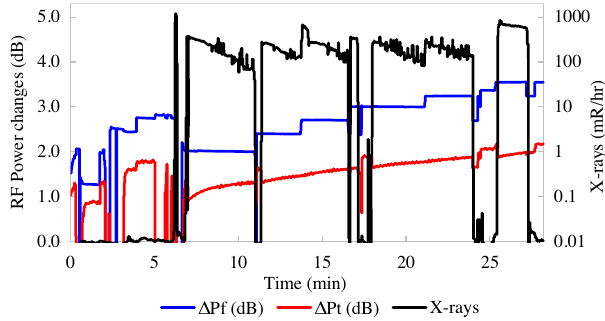
FIG. 6. RF conditioning of the cavity multipacting in the EP- only test. Pf and Pt are the forward and transmitted rf powers, respectively. The MP started to appear at an E ( t ¼ 0 . 3 min in this plot). The first three sudden drops of Pt ( t < 5 min) are due to the MP-induced thermal breakdown with no X-rays. After these events, X-rays were detected and we performed rf conditioning increasing the Pf stepwise. The MP was thoroughly conditioned and disappeared at an E 10 . 4 MV = m ( t ¼ 28 min). The X-ray detector was located to the side of the vertical test dewar, within 1 m from the cavity.